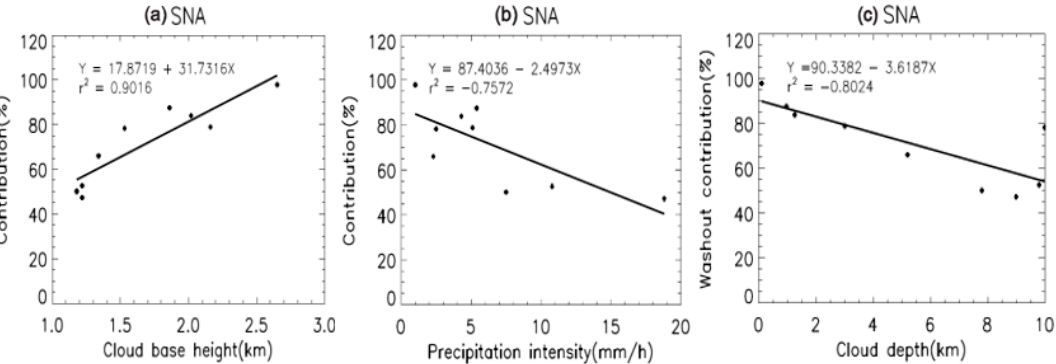
Figure 5. Scatterplots of the simulated washout contribution (%) from the total wet deposition flux against ( a ) the cloud base height (km), ( b ) precipitation intensity (mm h − 1 ), and ( c ) cloud depth (km). Washout contribution is calculated using the mean washout contribution of secondary inorganic aerosols. The solid lines indicate regression lines of the linear least-squares fitting.